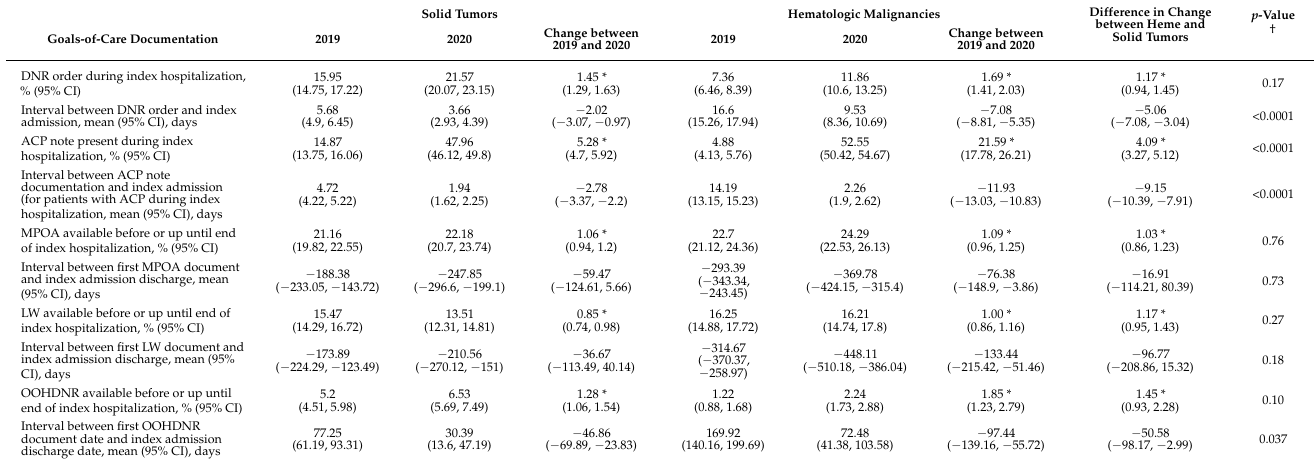
Table 3. Goals-of-care documentation before vs. after myGOC